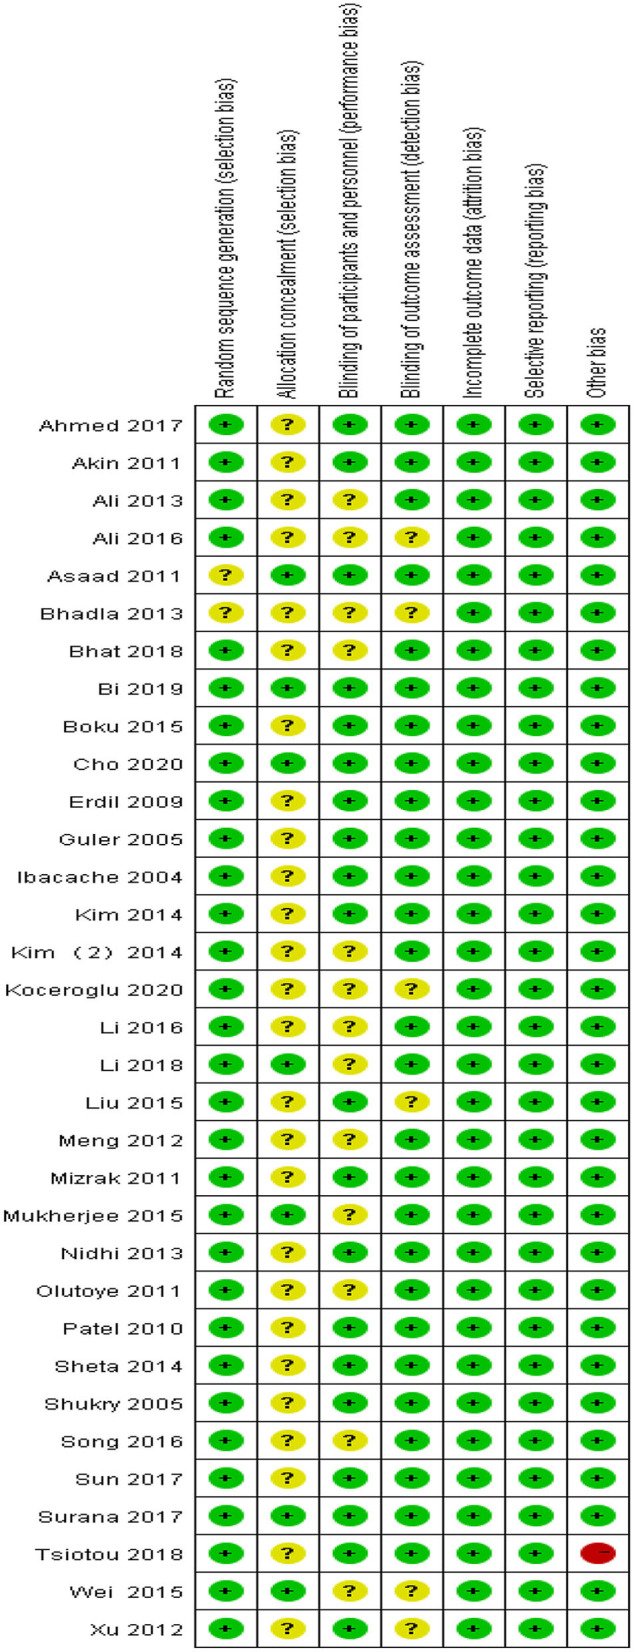
Risk-of-bias summary.